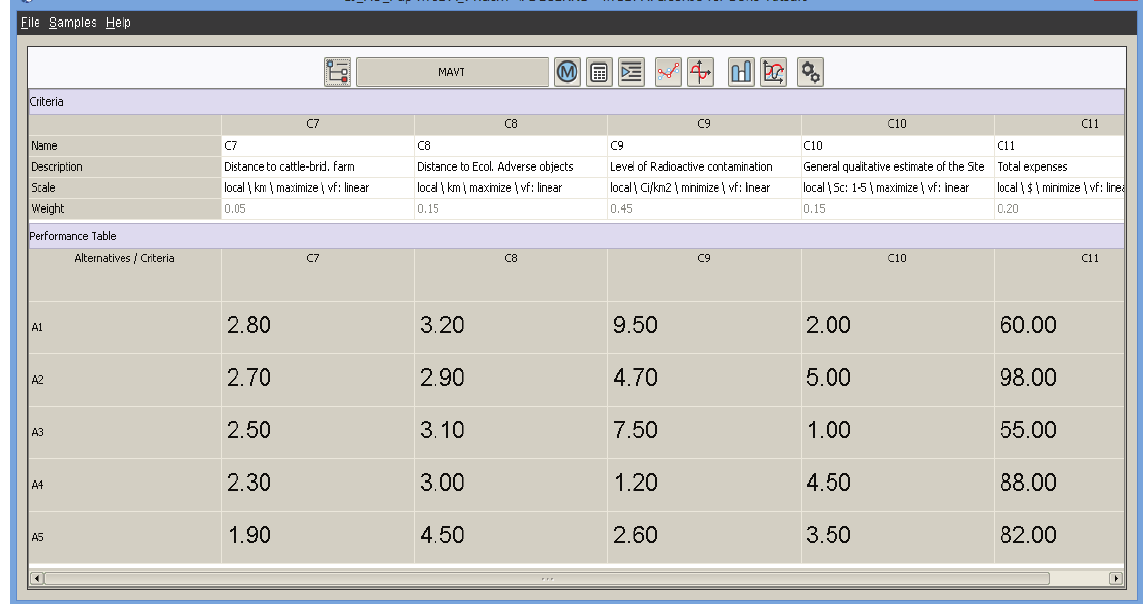
Fig.5. DecernsMCDA : Performance